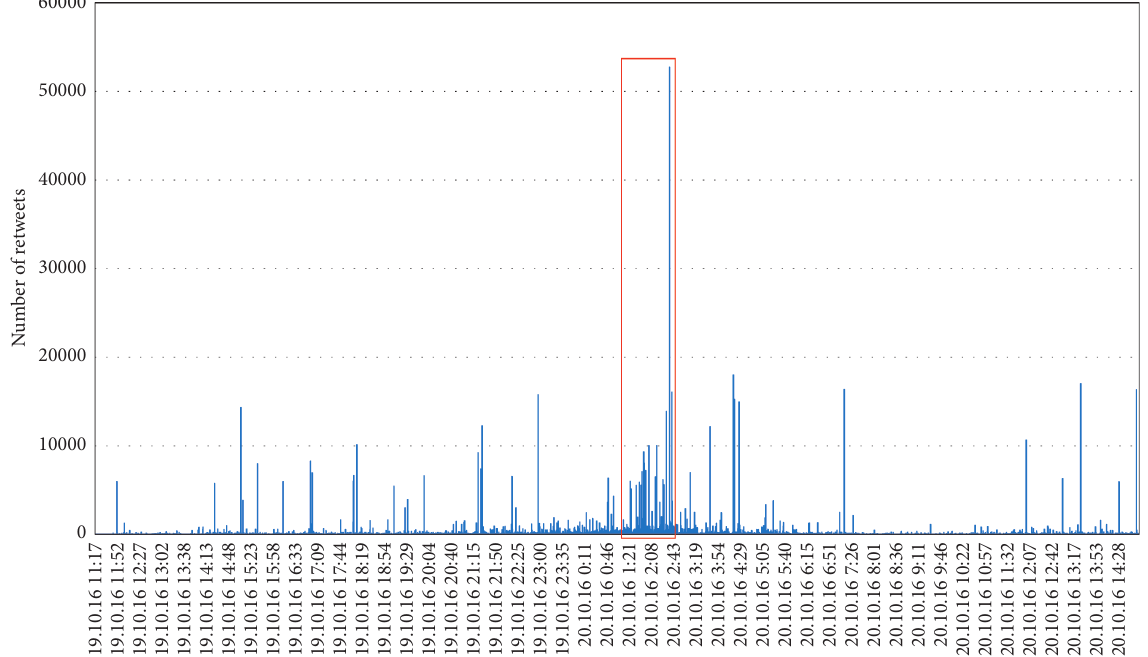
Figure 5: The dynamics of retweets corresponding to the third debate.